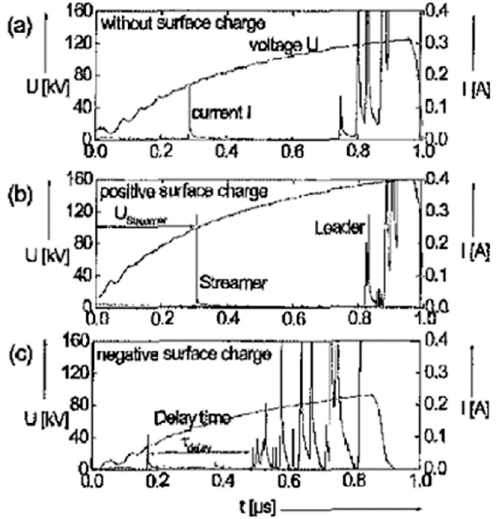
Figure 1. Instantaneous current and voltage during flashover at the surface of cylindrical epoxy insulator according to Reference [9].